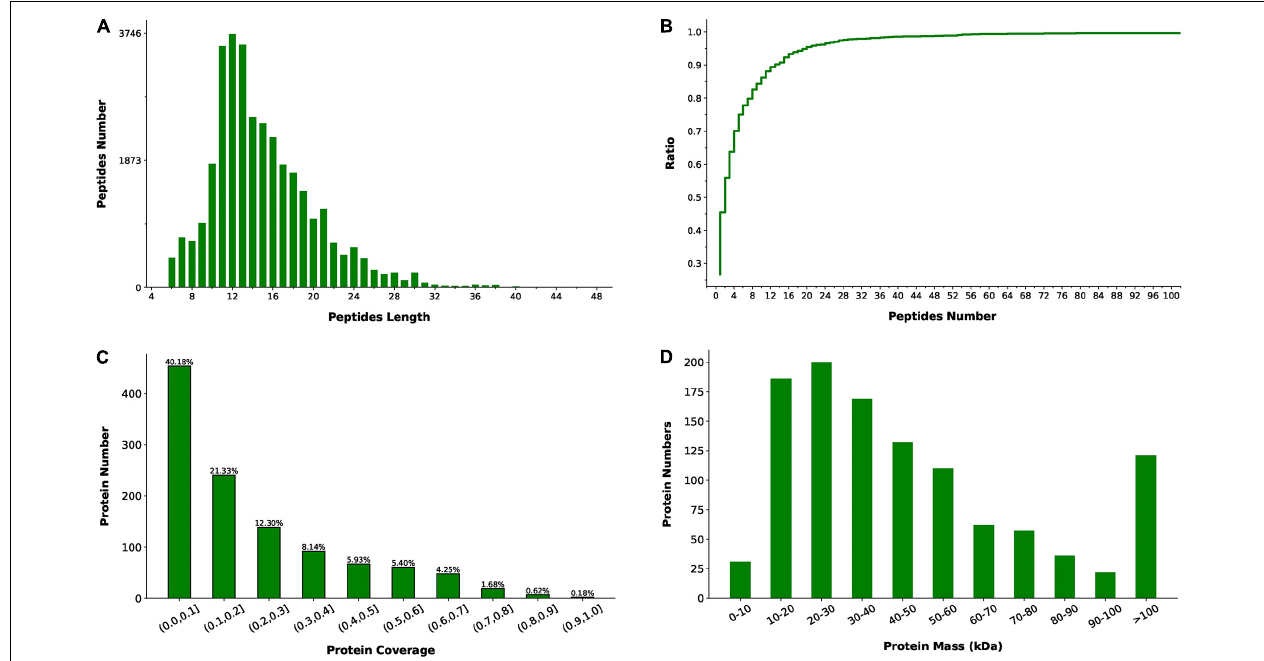
FIGURE 1 | Peptides and proteins identified by liquid chromatography-tandem mass spectrometry (LC-MS/MS) in slow-twitch muscle and fast-twitch muscle of P. dentex . (A) Length distribution of the identified peptides. Peptides length is the number of amino acid residues. (B) Number distribution of unique peptides. The ratio (y-axis) represents the cumulative proportion of proteins containing unique peptides to the total proteins as the number of unique peptides increases. (C) Coverage of identified peptides to the entire protein sequence. The x-axis represents the interval of protein coverage (the length of the protein covered by the detected peptide/the full length of the peptide). The y-axis represents the number of proteins corresponding to the interval. (D) Distribution of identified protein molecular weight.